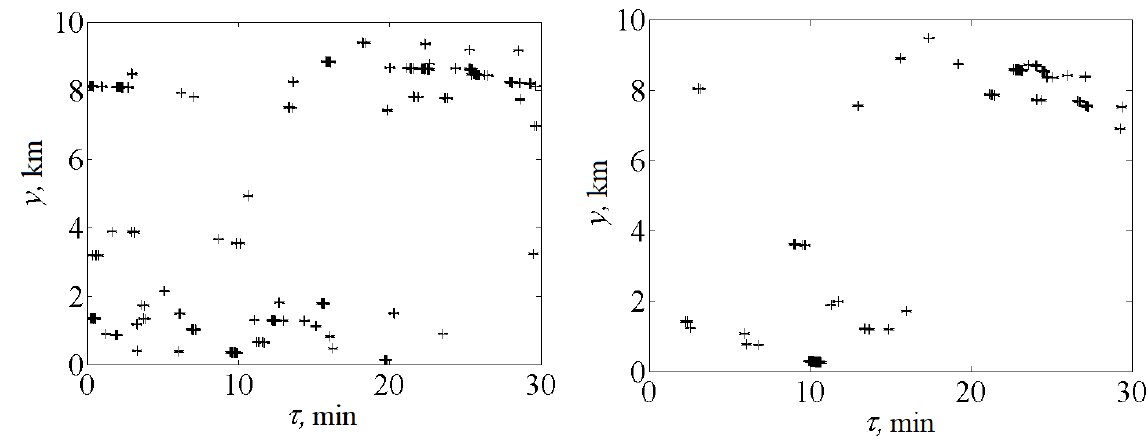
Figure 5. Spatiotemporal diagram for 𝜂 > 3 m ( left ) and 𝜂 < 3 m ( right ).